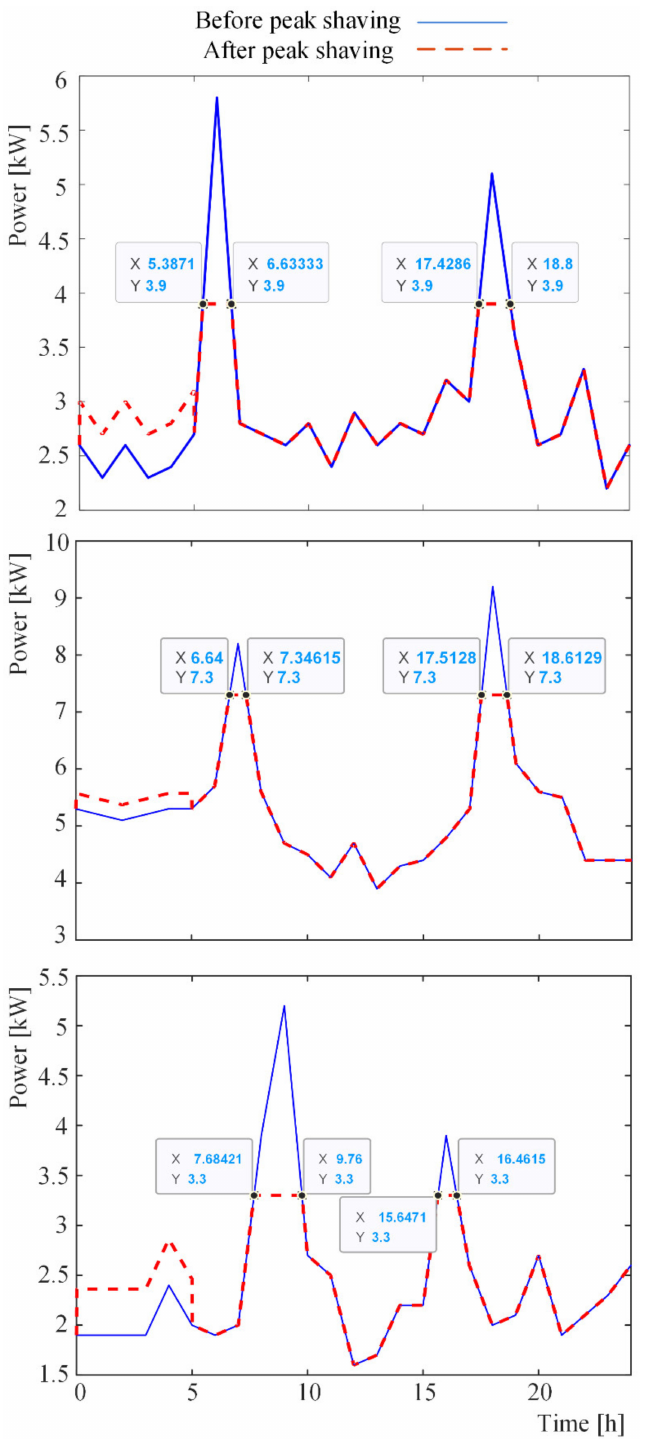
Figure 22. Load profile before and after peak shaving in three different households and discharging times for different